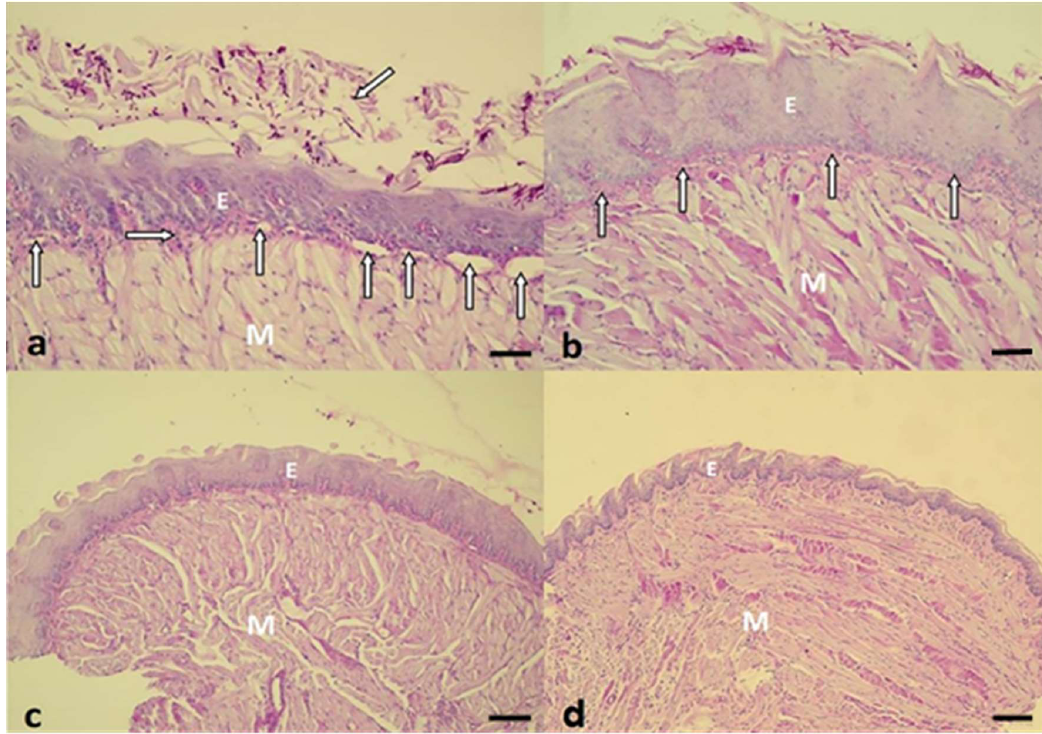
Figure 5. ( a ) Histological section observed in the P-L- group. There are numerous hyphaes and pseudohyphaes over the thick keratin layer (oblique arrow). Below the epithelium (E), a thin lamina propria was observed (horizontal arrow), an intense inflammatory reaction, with the presence of several dilated blood vessels (vertical arrows). The intact muscle tissue (M) is stained with Periodic Acid Schiff and Hematoxylin (PAS-H 250x). ( b ) A representative image of the NYS+P+L+ group shows the keratinized stratified acanthotic epithelium (E) covering the central portion of the tongue. The interlocking bundles of muscle tissue (M), intact epithelium, and thin layer of connective tissue (vertical arrows), exhibiting a discrete inflammatory reaction, should be noted (PAS-H 250x). ( c ) The P+L+NYS+ group presented the epithelium with lingual papillae covering the thin keratin layer. The stratified squamous epithelium demonstrated normalized histological characteristics (PAS-H 64x). ( d ) The NIC group showed a stratified squamous epithelium that masks the homogeneity of the tongue. There is a large volume of muscle tissue (M), which constitutes the major part of the tongue. All these events in the groups were observed after 24 h of treatment (PAS-H 64x). Scale bar: 20 µm